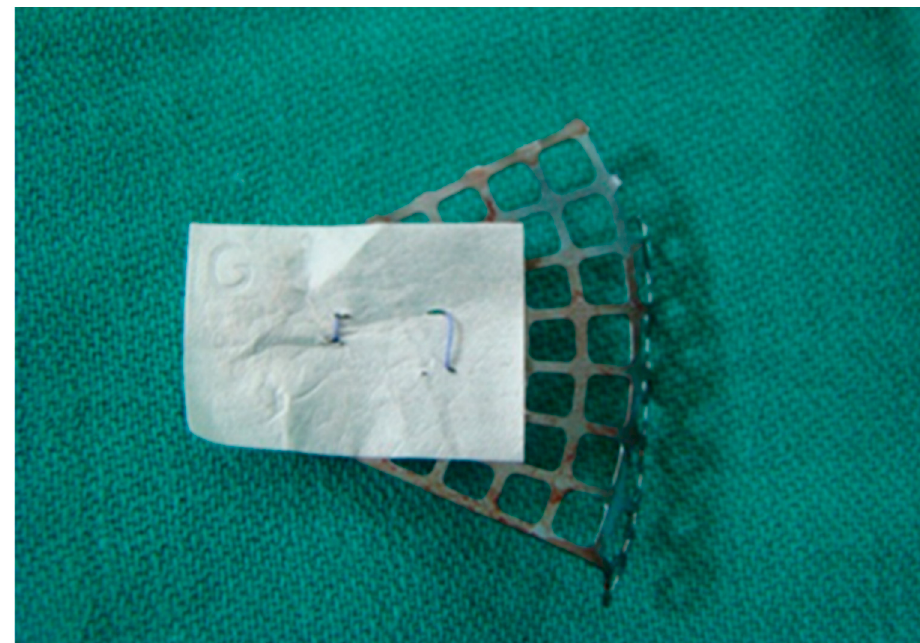
Figure 1. Collagen membrane partially covering the titanium orbital mesh plate and fixed via sutures.